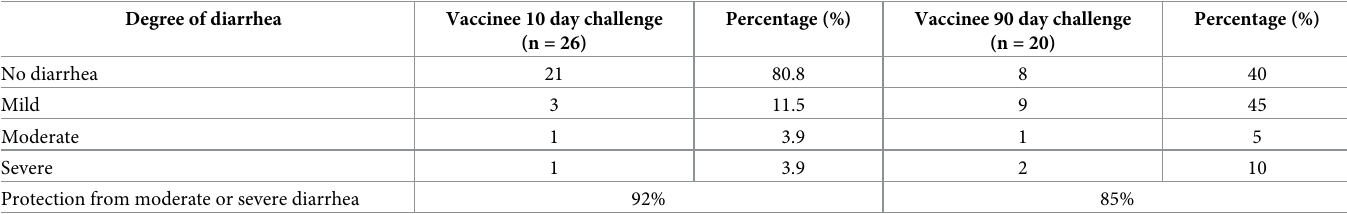
Table 2. Protection afforded by oral cholera vaccine CVD 103-HgR against diarrhea following subsequent experimental challenge [10]. Degree of